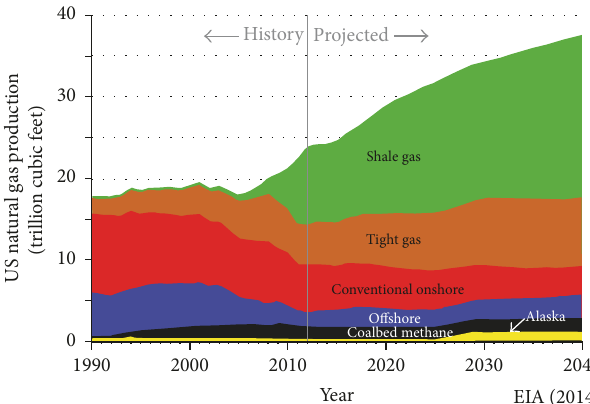
Figure 1: Projected growth of US shale-gas production [2].